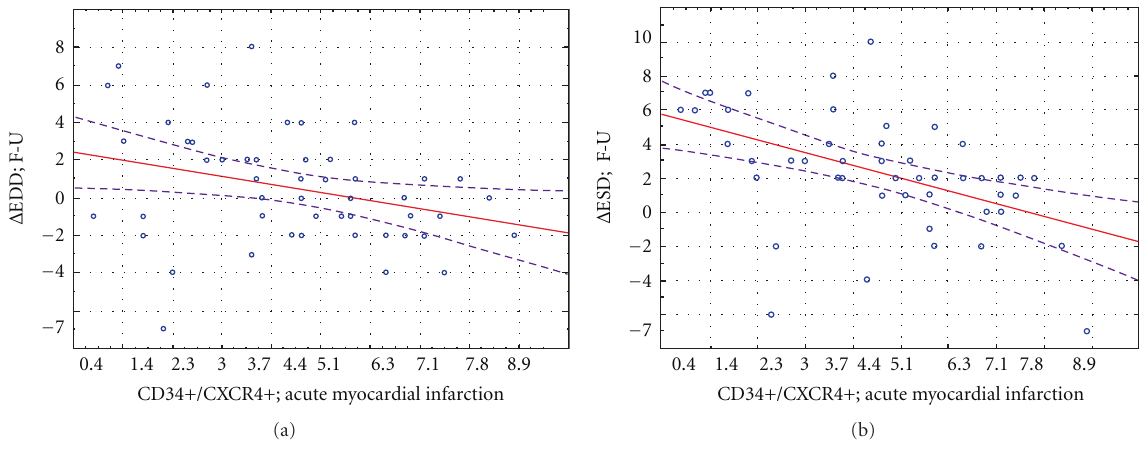
Figure 9: Correlation of CD34+CXCR4+ progenitor cell number in the acute phase of MI with the absolute EDD change ( Δ EDD) and ESD ( Δ ESD) in 12-month clinical observation. Table 4: Results of ergospirometry.